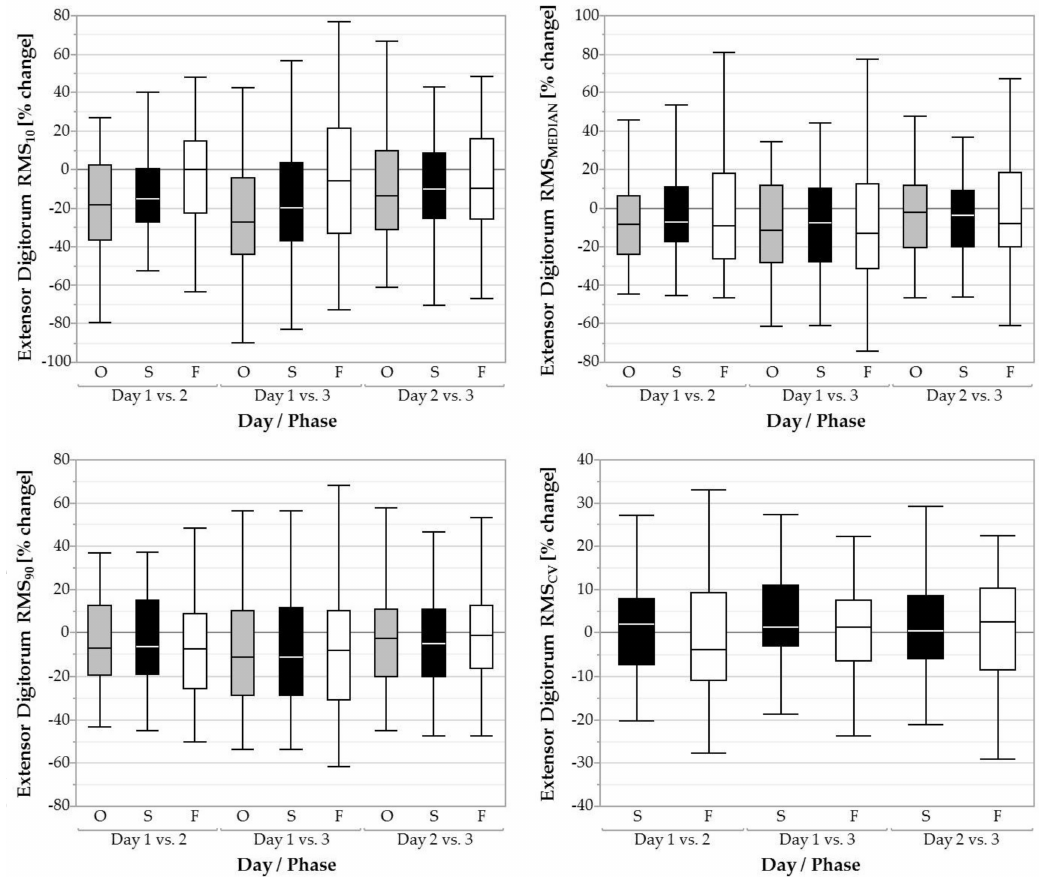
Figure 5. Boxplots of the 10th, 50th,and 90th percentile muscular activity (RMS 10 , RMS MEDIAN , RMS 90 ) and coefficient of variation (RMSV) of the extensor digitorum over three days for the overall task (O, grey filled boxplots), the screwing phases (S, black filled boxplots), and the fastening phases (F, white filled